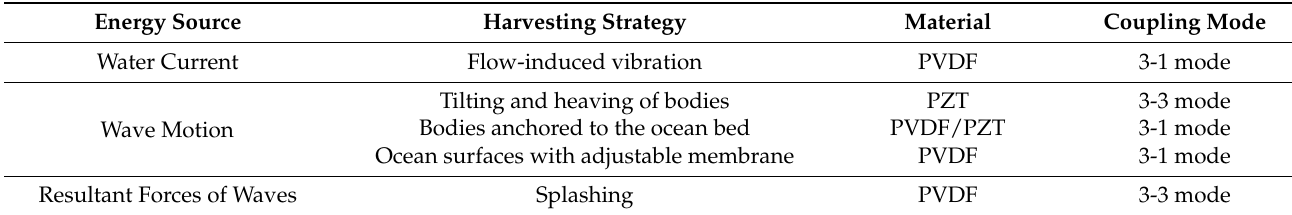
Table 5. Energy Harvesting Strategies.